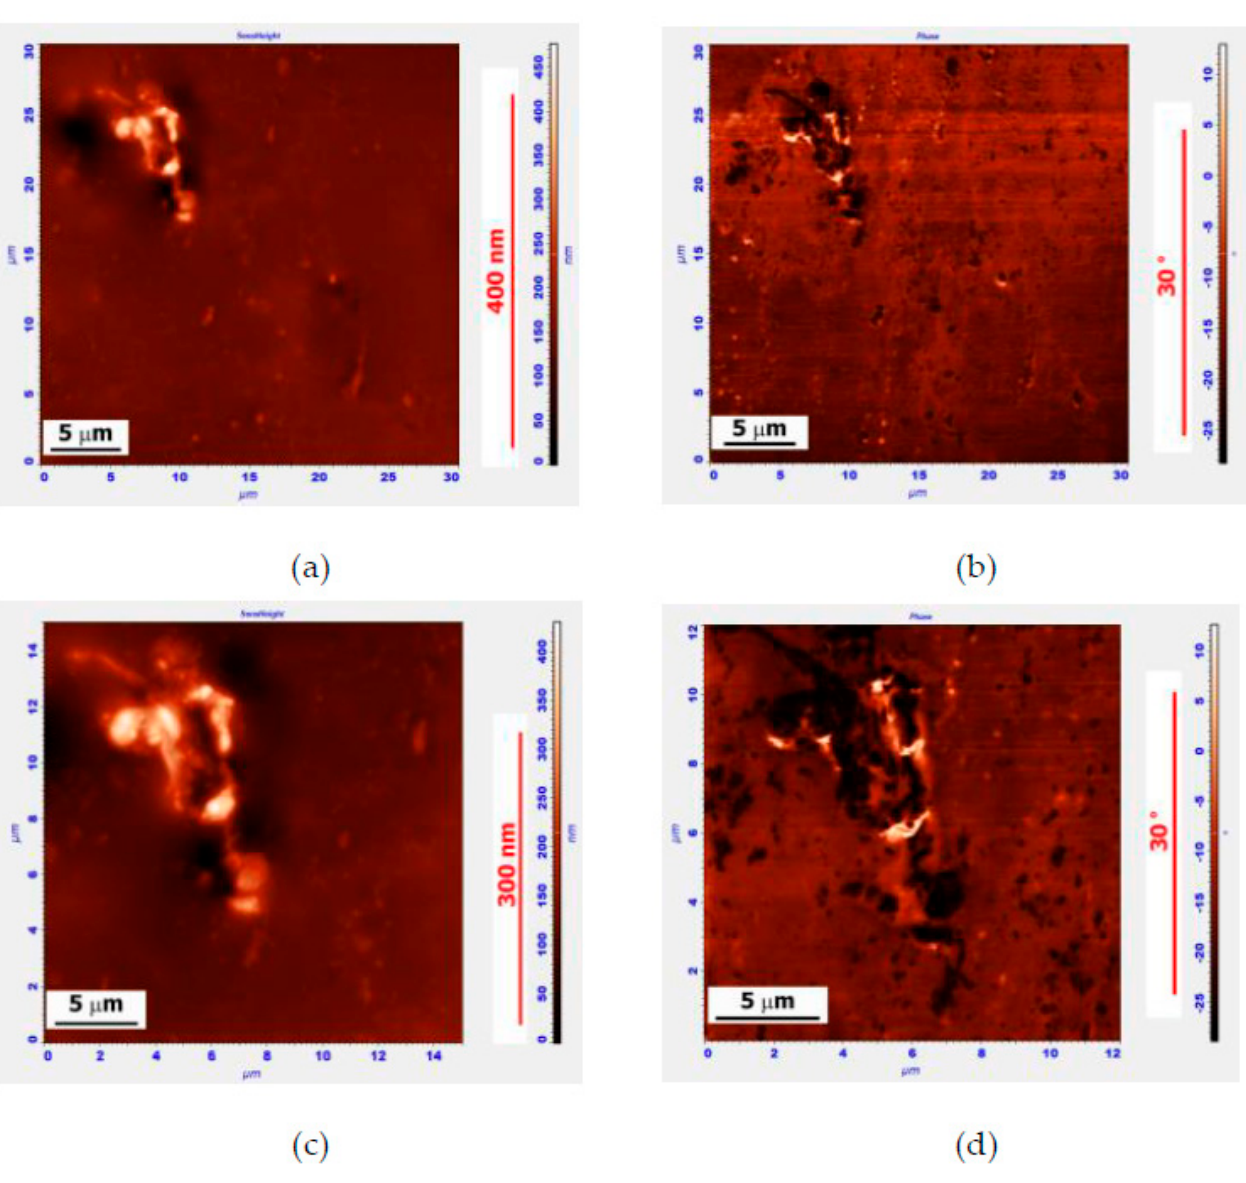
Figure 2. AFM surface images of the MB sample of 85 wt.% Bit-A + 15 wt.% APDDR, obtained 2 days after sample preparation. Topography (left), phase image (right): ( a , b )—30 × 30 μ m, ( a ) Z-coordinate—470 nm; ( c , d )—12 × 12 μ m, ( c ) Z-coordinate—470 nm.